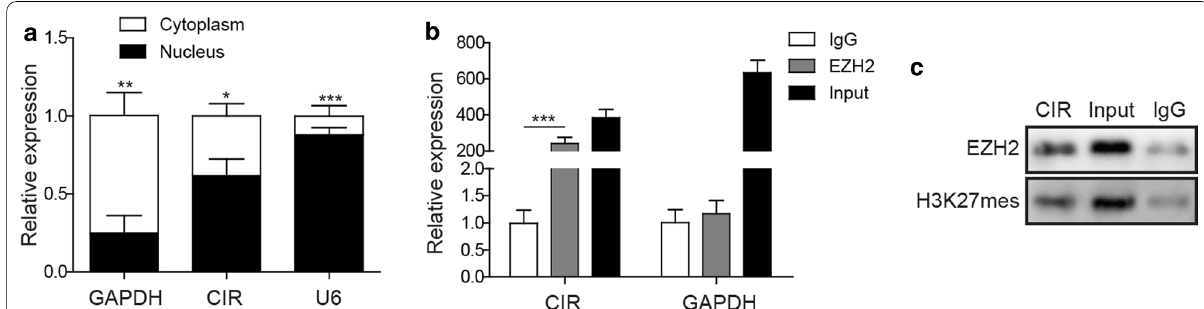
Fig. 4 LncRNA CIR directly binds to EZH2. a qRT‑PCR analysis of lncRNA CIR level in cytoplasm and nucleus. b RIP assay was performed to analyze lncRNA CIR/EZH2 interaction. c Biotin‑RNA pull down assay was used to measure the interactions of lncRNA CIR with EZH2 and H3K27me3.